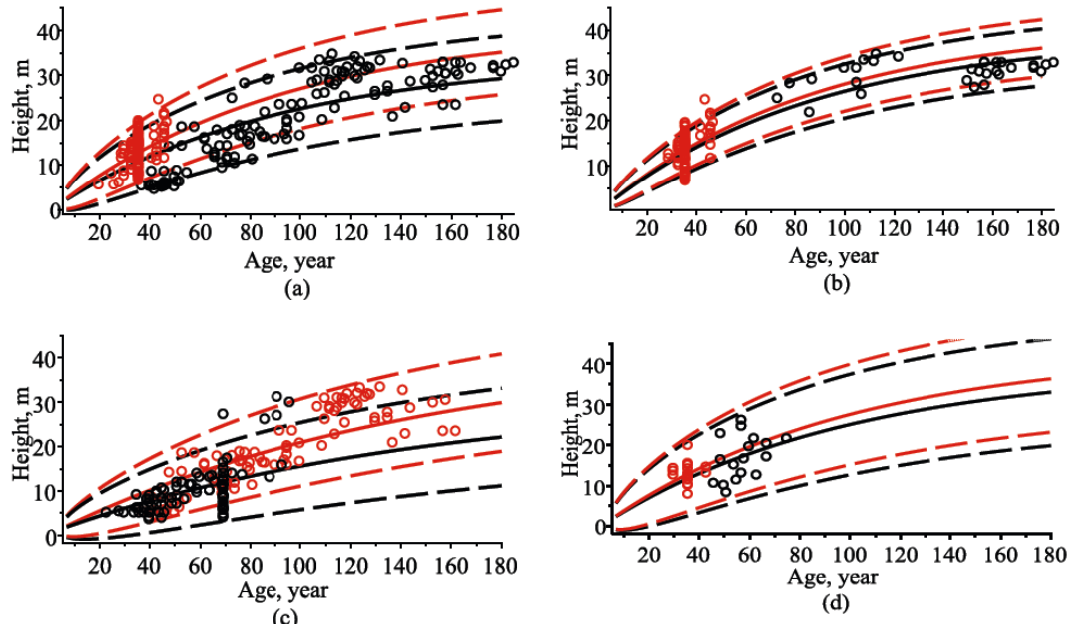
Figure 4. Kinetics of the mean, 0.05 quantile, and 0.95 quantile of the height for two randomly selected stands from a validation dataset: ( a ) all species; ( b ) pine ( Pinus sylvestris ); ( c ) spruce ( Picea abies) ; ( d ) silver birch ( Betula pendula Roth and Betula pubescens Ehrh.); solid line — mean trajectory; dashed line — quantiles trajectories; black — first stand; red — second stand; and circles — observed data.